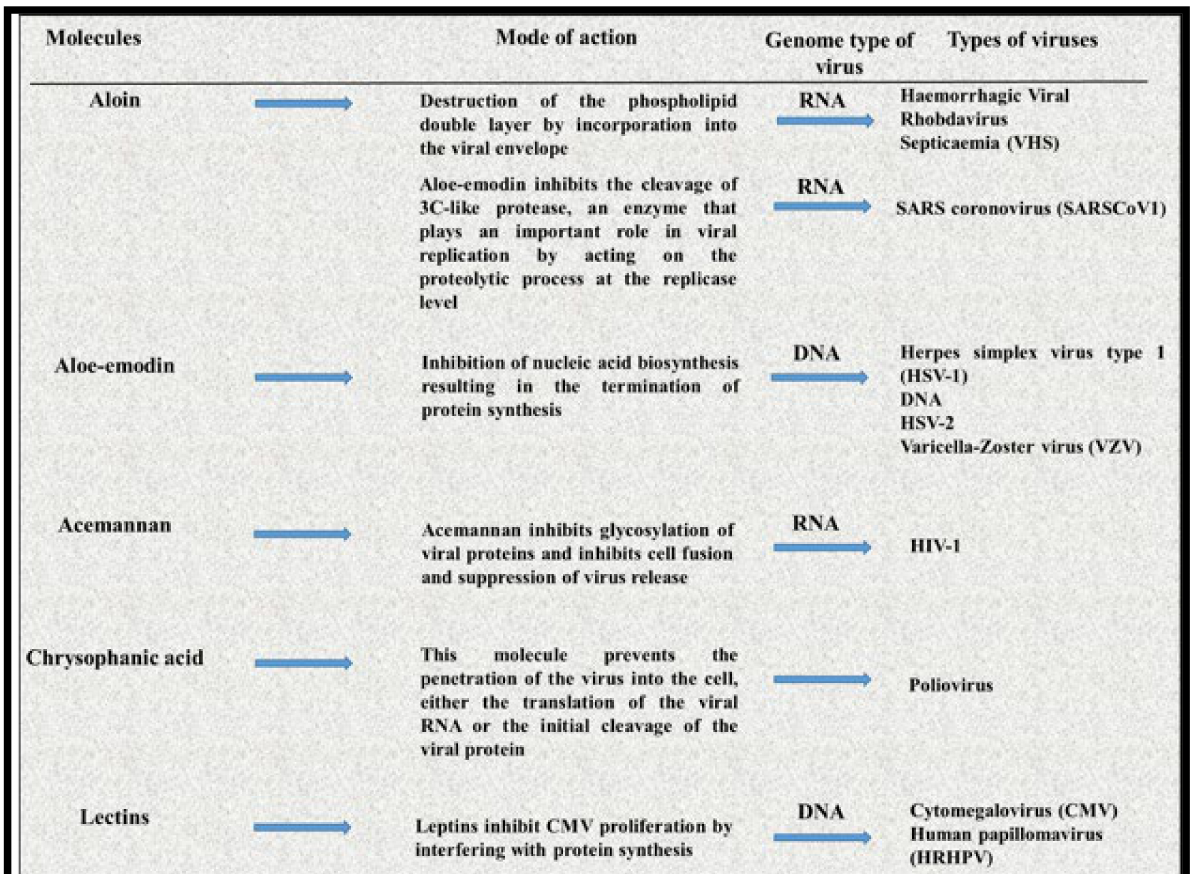
Figure 3. Antioxidant properties of Aloe vera